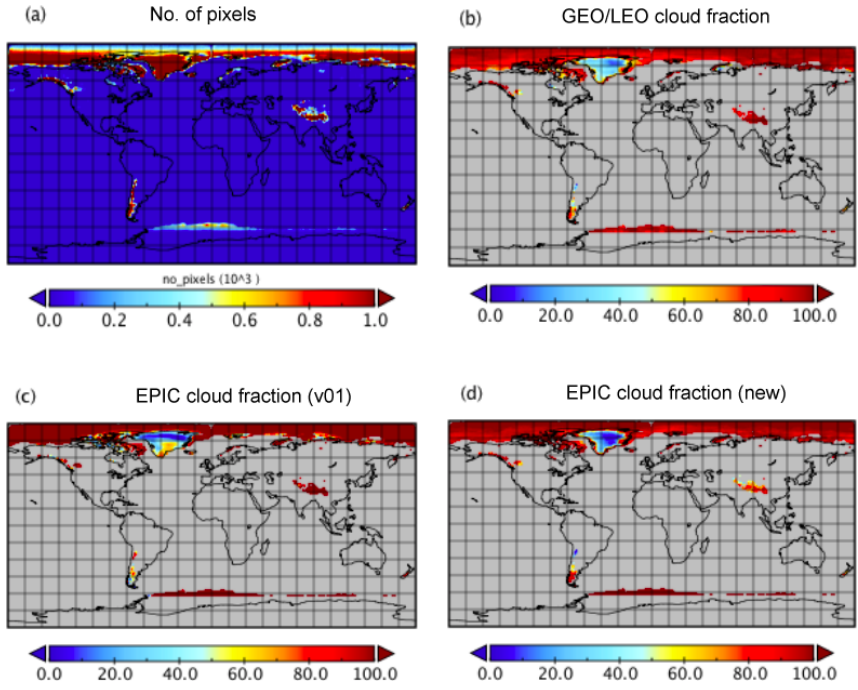
Figure 10. (a) Number of ice/snow pixels and monthly mean cloud fractions derived from (b) GEO/LEO composites, (c) original EPIC cloud mask algorithm, and (d) new algorithm in 1 ◦ × 1 ◦ grids for July 2017.